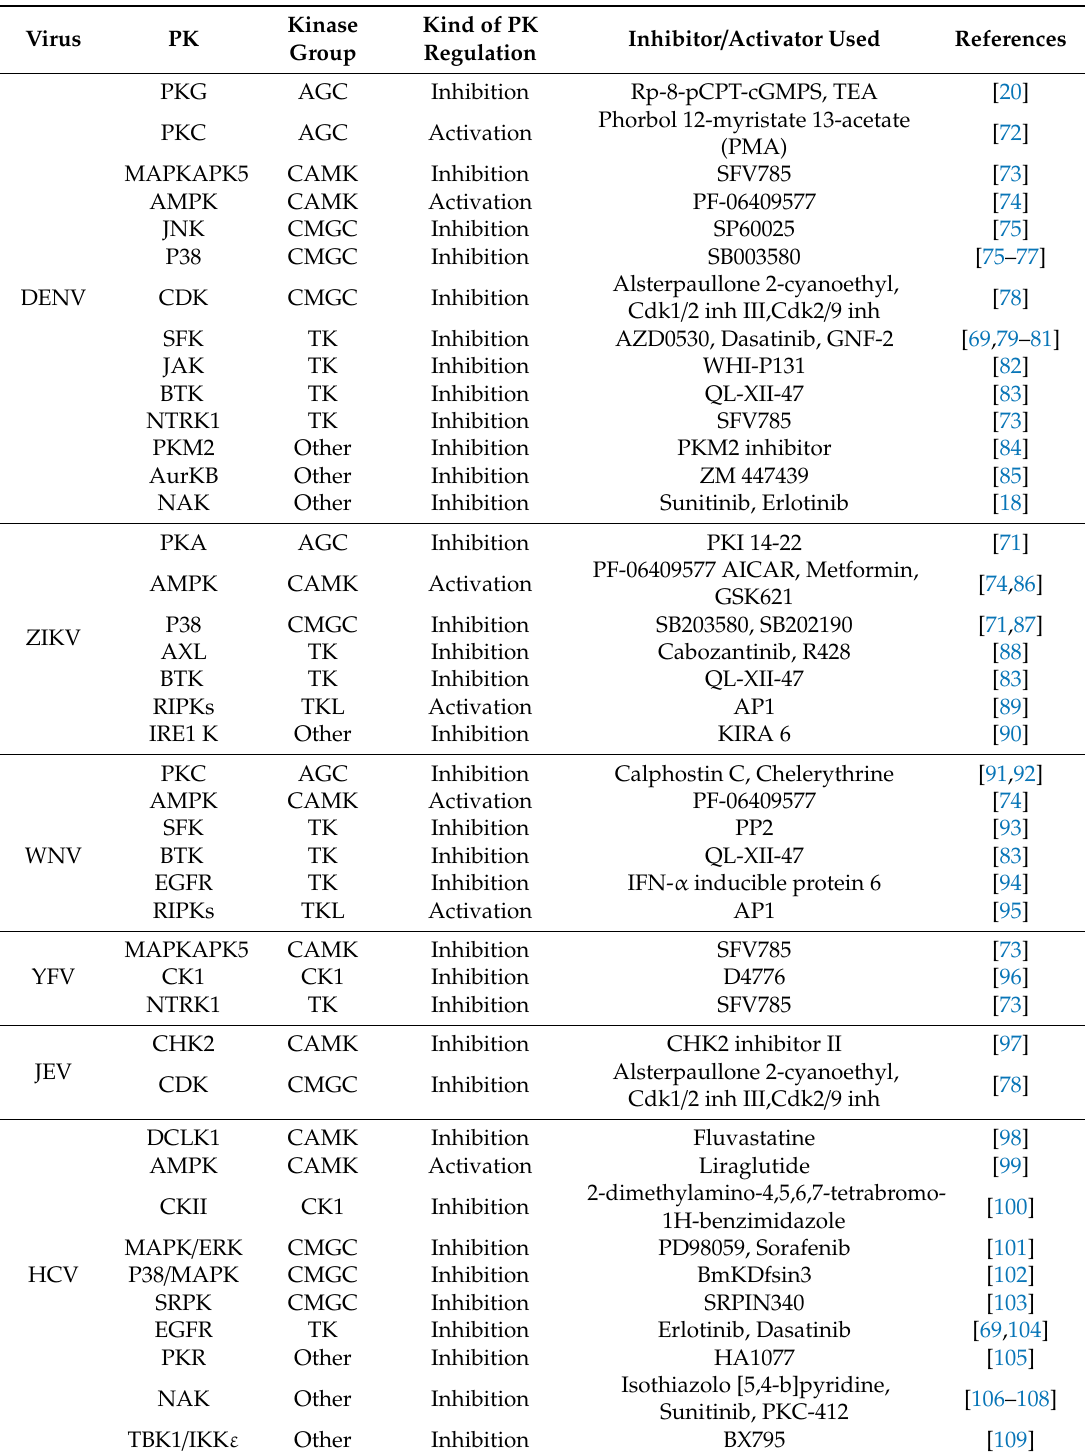
Table 4. Members of the Flaviviridae family inhibited by PK